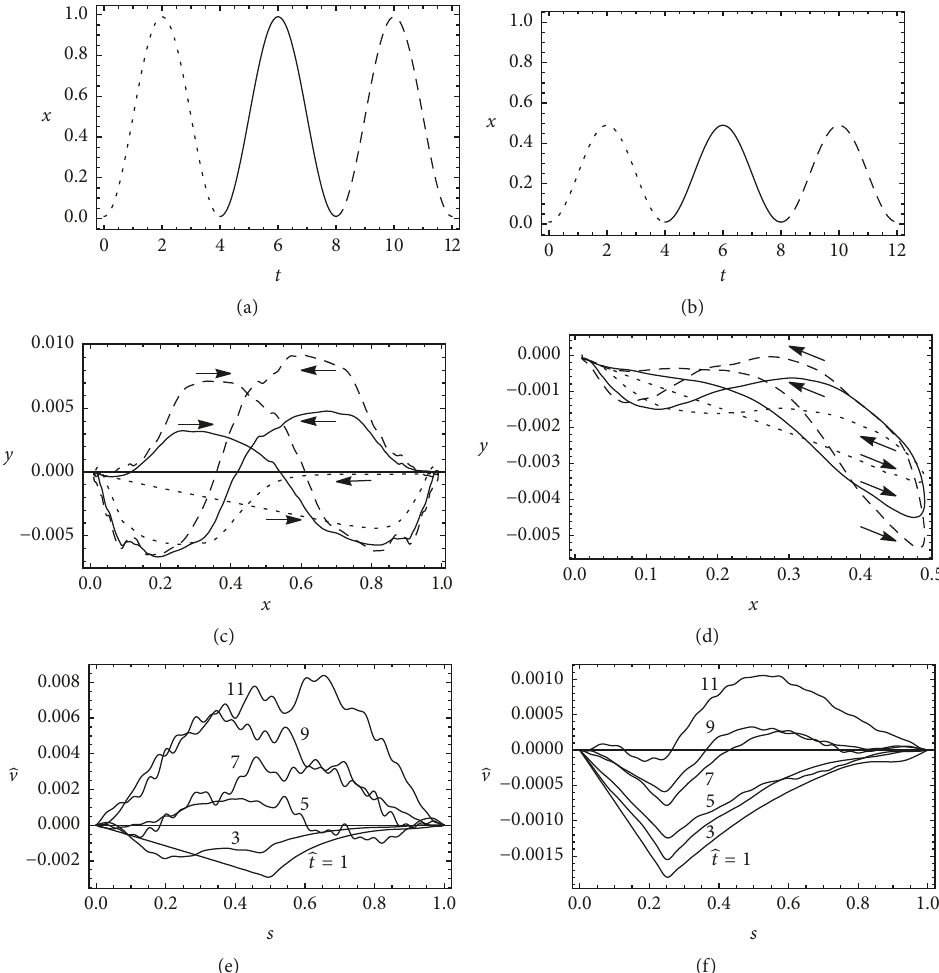
Figure 4: Back and forth motion, when 𝑃 = 0.01 , 𝜇 = 0.1 , 𝜉 0 = 0.01 , and 𝑡 𝑡 = 4 ; 𝑁 𝑒 = 50 : (a), (c), (e) 𝑎 = 0.98 ; (b), (d), (f) 𝑎 = 0.48 . The symbol ̂ V denotes V (𝑠,̂𝑡)